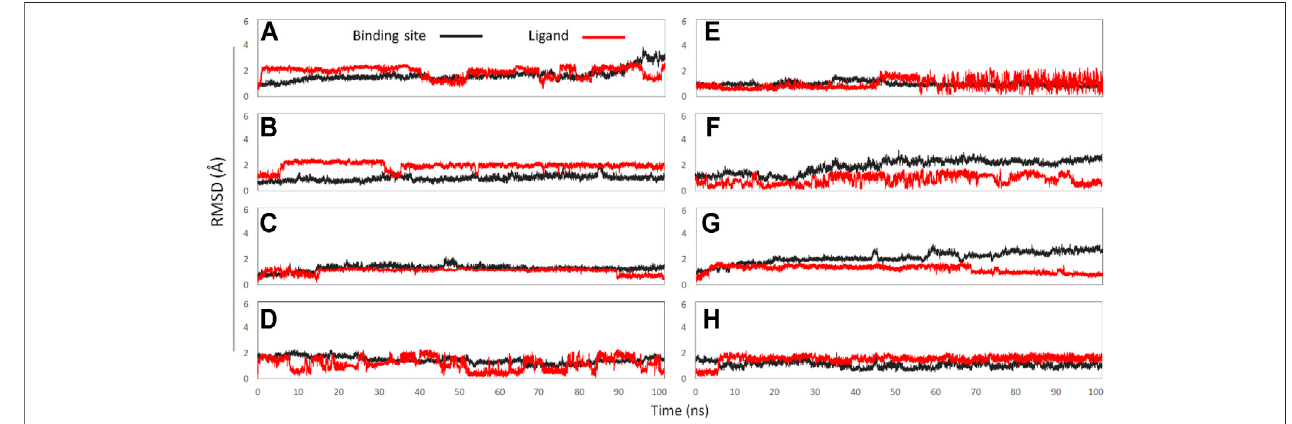
FIGURE 7 | The RMSD values of binding sites (black line) and ligand (red line): (A) GAS in Site 1; (B) GAS in Site 2; (C) GAS in Site 3; (D) GAS in Site 4; (E) GAS in Site 5; (F) GAS in Site 6; (G) GAS in Site 7; (H) GAS in Site 8.